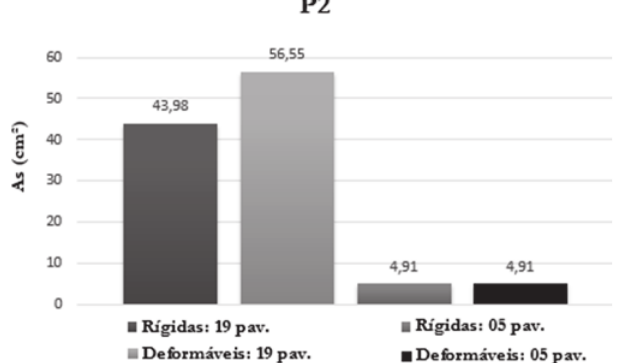
Figura 13 Modelo de Ferreira, El Debs e Elliot [1]: γ ligações rígidas e ligações deformáveis armadura do pilar P2 da estrutura com 19 e